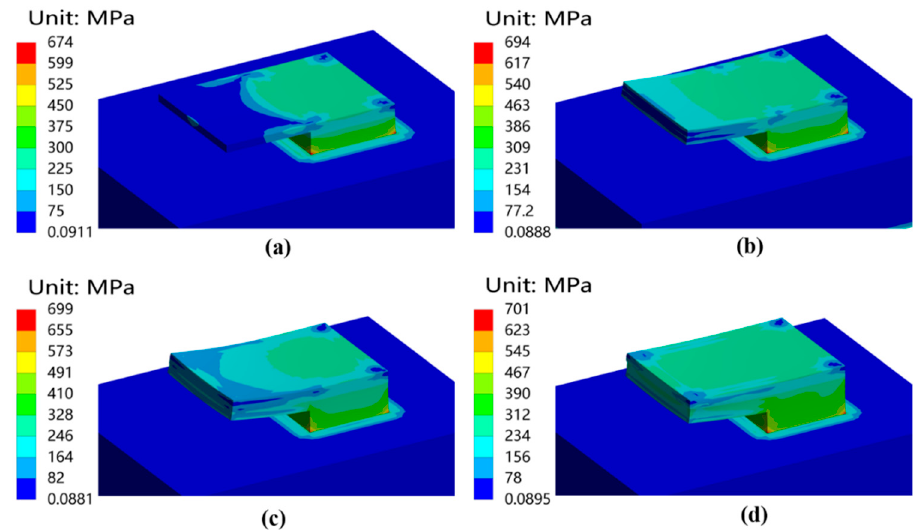
Figure 12. Residual stress: ( a ) Layer 1; ( b ) Layer 2; ( c ) Layer 3; and ( d ) Layer 4.